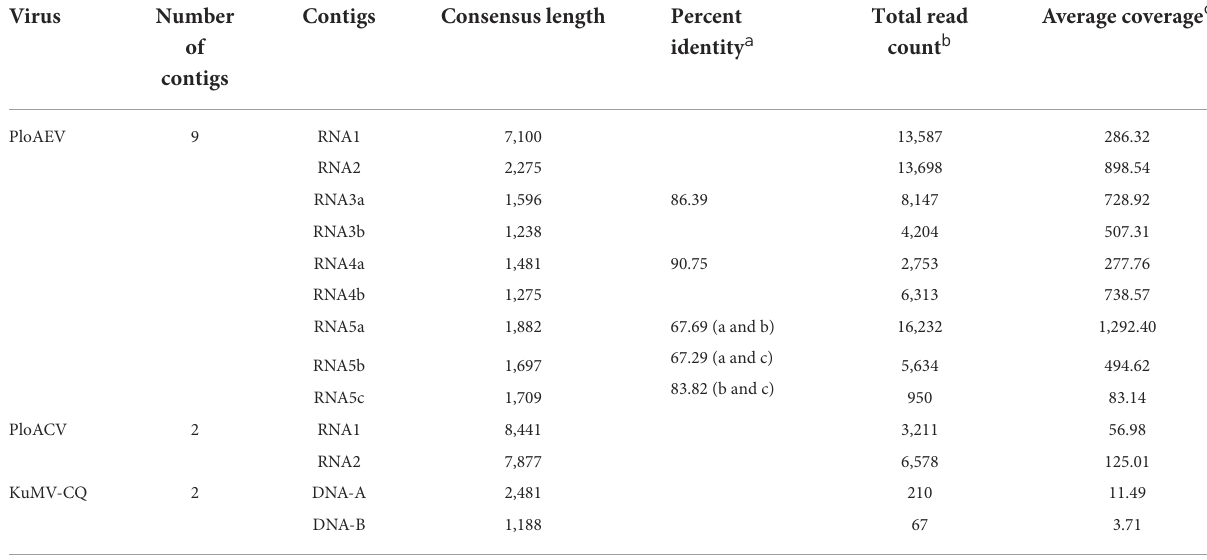
TABLE 1 Analysis of HTS data from the diseased leaves of P. lobate .